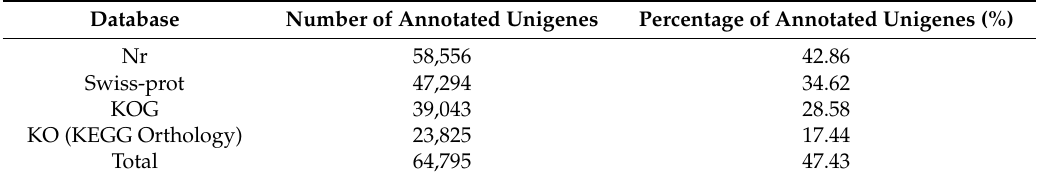
Table 2. The statistics of annotation on unigenes against public databases.